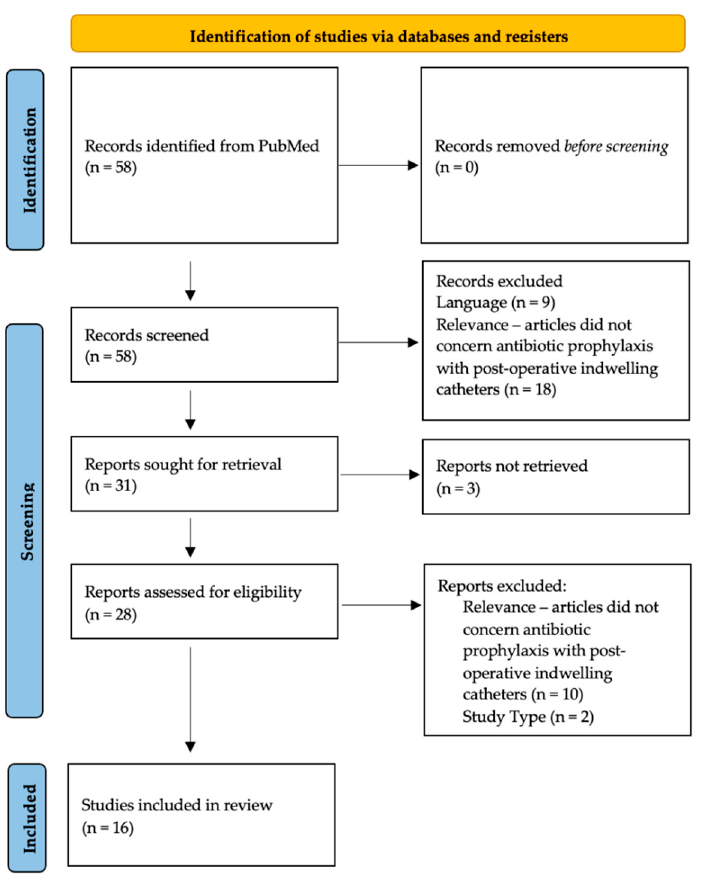
Figure 1. Identification and exclusion of studies for this literature